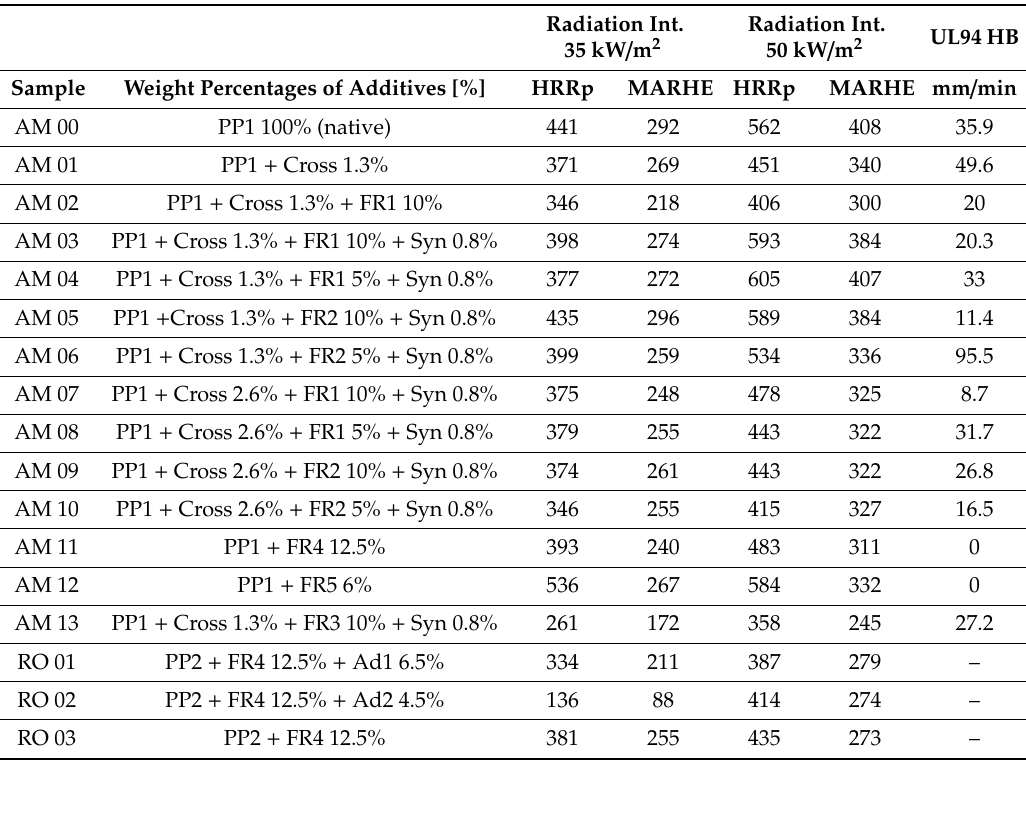
Table 5. Fire properties (HRRpeak and MARHE) of PP with various additives for radiation intensity 35 and 50 kW / m 2 and horizontal burning (UL 94 HB) with result burning length.